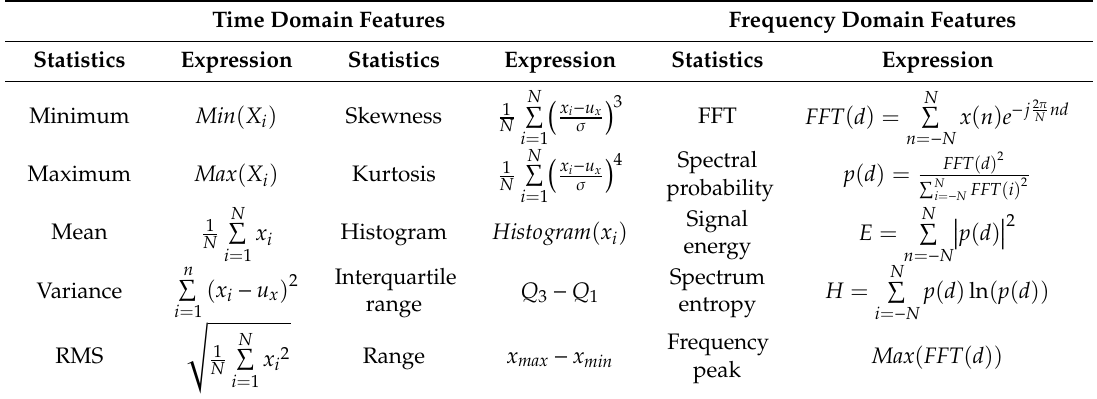
Table 5. Time and frequency domain statistical